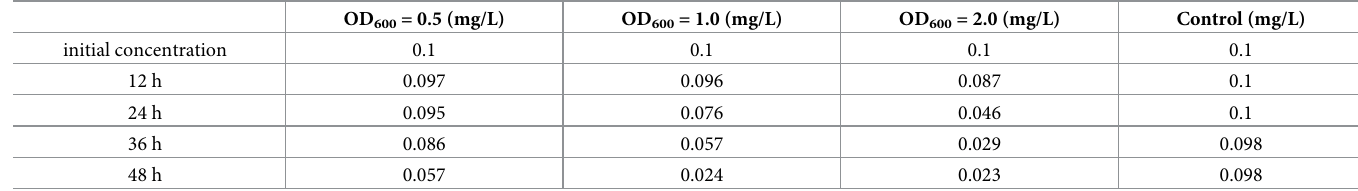
Table 3. The average residual concentration of deltamethrin in each group of media at different culture duration.